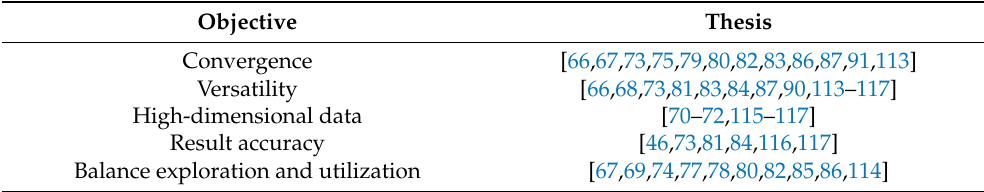
Table 5. An objective analysis of the PSO